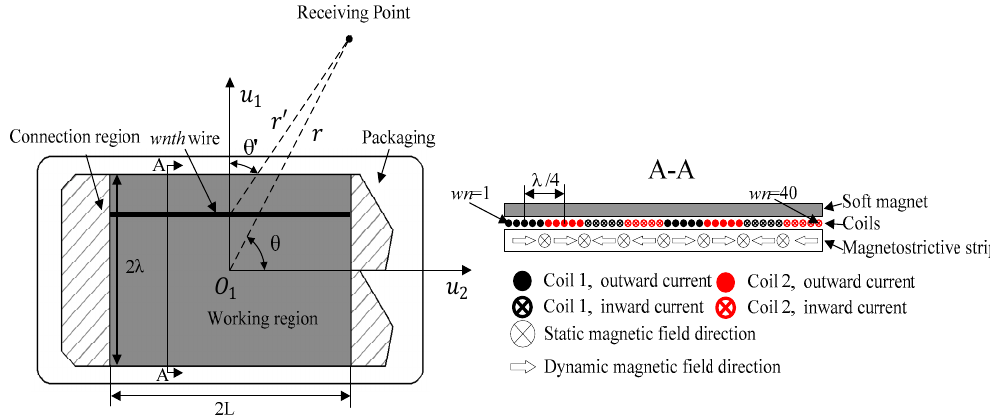
Figure 4. The structure of the magnetostrictive sandwich transducer (MST).